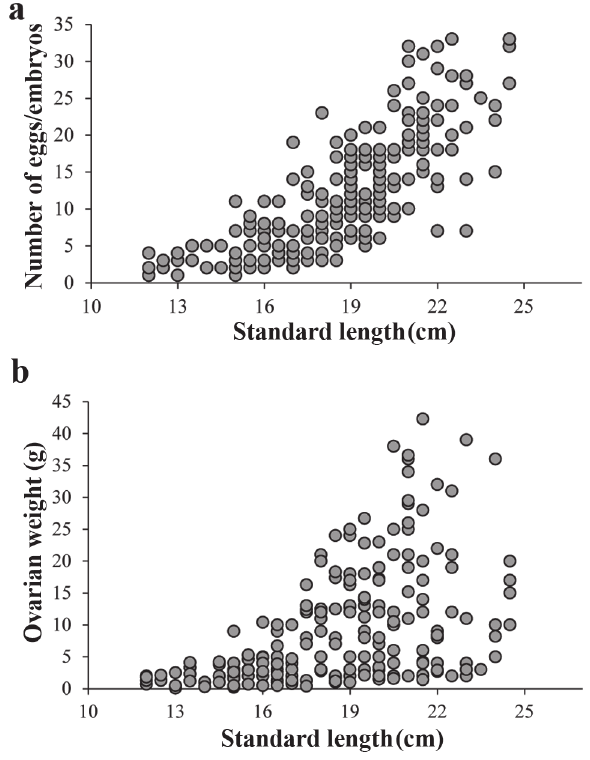
Fig. 9. Number of eggs/embryos ( a ) and ovarian weight ( b ) relative to body size (standard length) recorded in Anableps anableps females from the mouth of the Maracanã River,